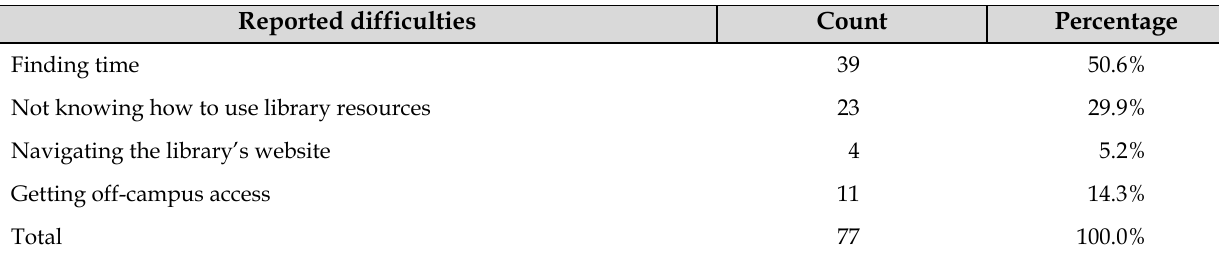
Table 2 Overall frequency of reported